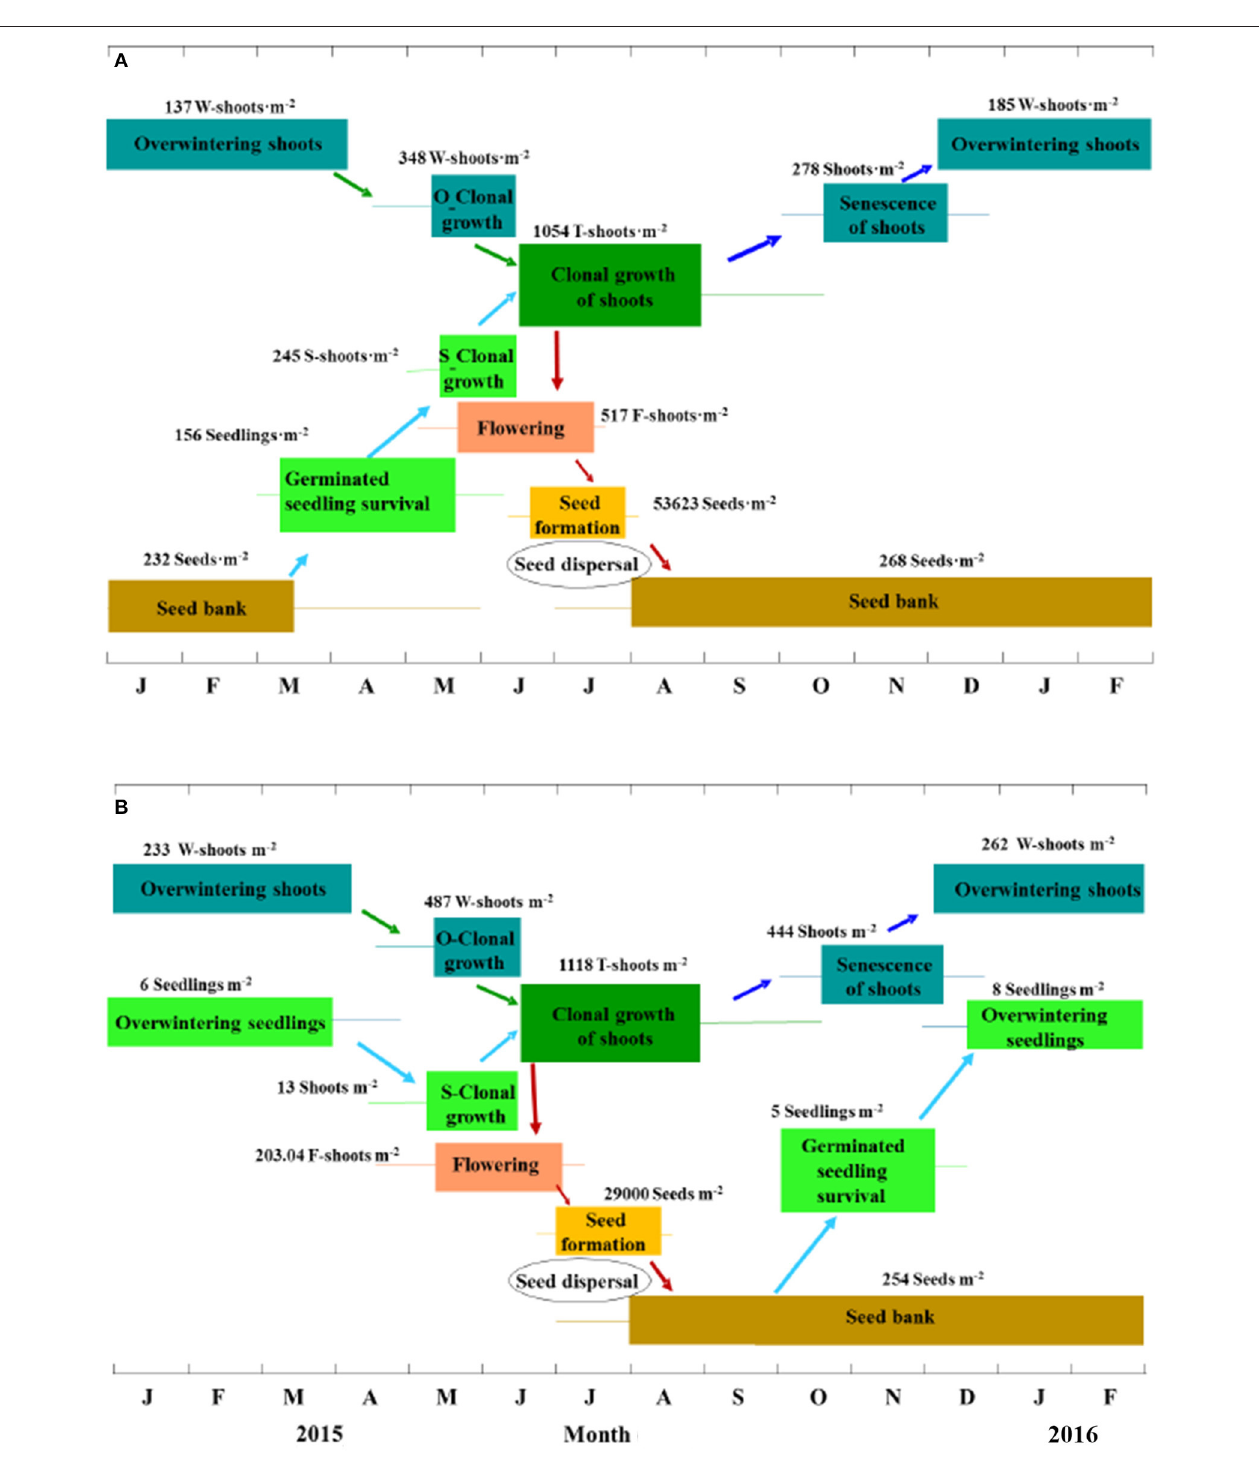
FIGURE 11 | The reproduction and recruitment cycle of Zostera marina in Swan Lake (A) and Huiquan Bay (B) , China. The colored lines and rectangles represent the accidental and the main timing of different stages within the reproduction and recruitment cycle, respectively; O-Clonal growth and S-Clonal growth represent clonal growth of overwintering shoots and seedlings, respectively; W-shoots, S-shoots, T-shoots, and F-shoots refer to overwintering shoots and shoots from their clonal growth, seedling shoots, total shoots and flowering shoots, respectively. Values (means) are based on the investigation in 2015 and represent the peaks of each stage. Four processes are involved in this cycle: (A) i, seed germination from mid-March, seedling establishment beginning in April and completed at mid-June